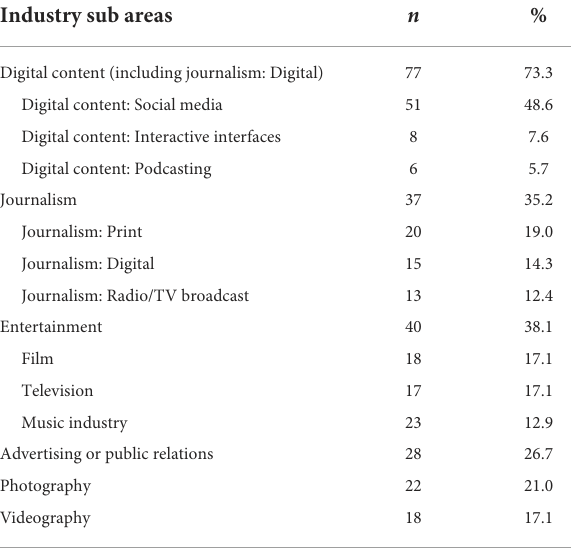
TABLE 2 Study 2 respondent industry